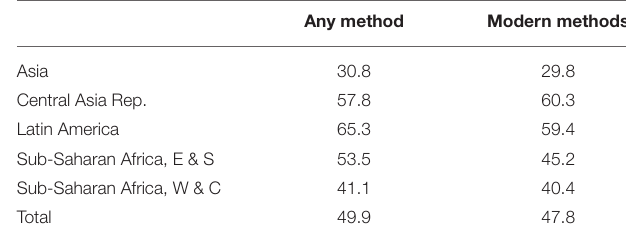
urban and rural environments is subject to somewhat different sets of determinants across the regions.